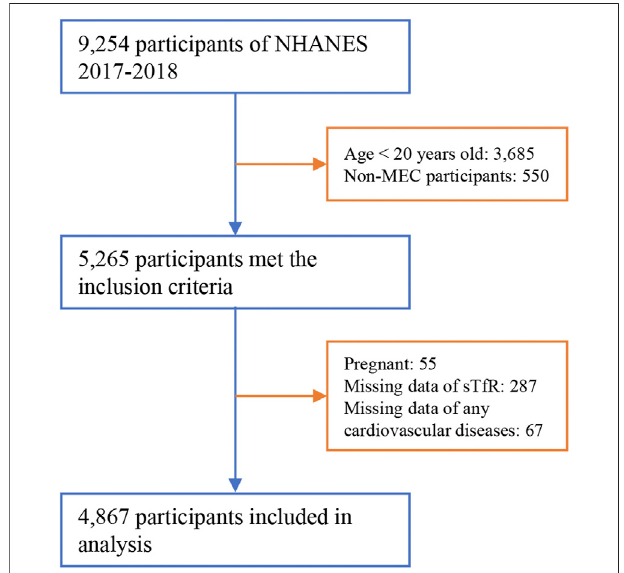
FIGURE 1 | Flow chart of the